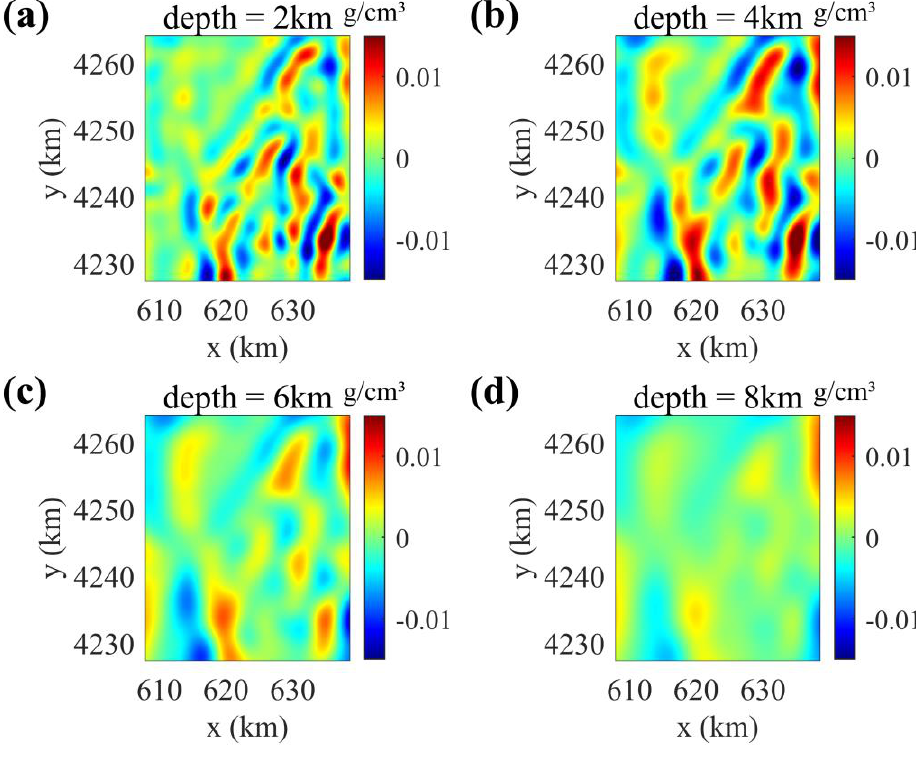
Figure 6. The horizontal section of the inversion results at ( a ) 2 km; ( b ) 4 km; ( c ) 6 km; ( d ) 8 km.